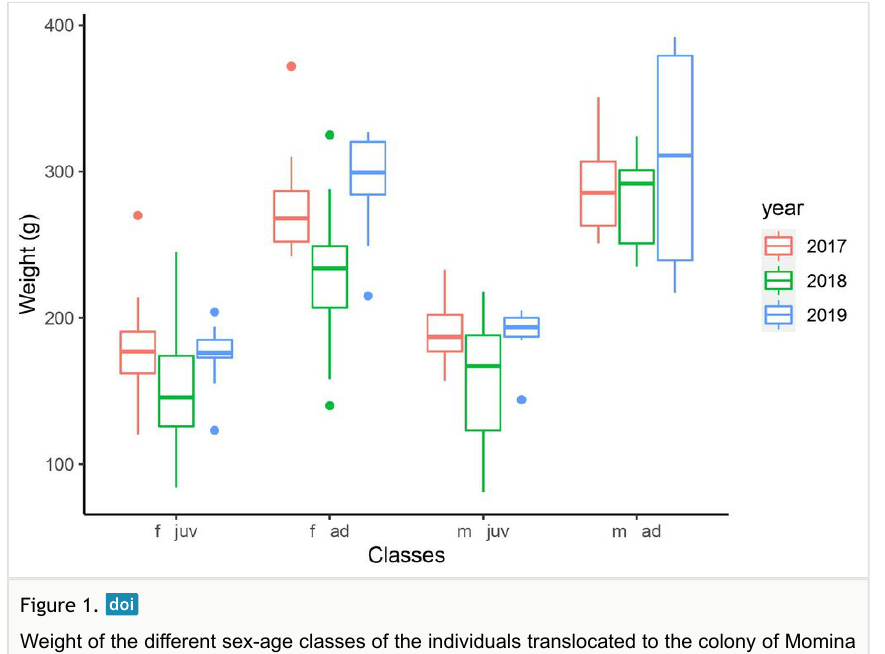
Weight of the different sex-age classes of the individuals translocated to the colony of Momina tsarkva in each year between 2017 and 2019, f - female, m - male, ad - adult, juv -